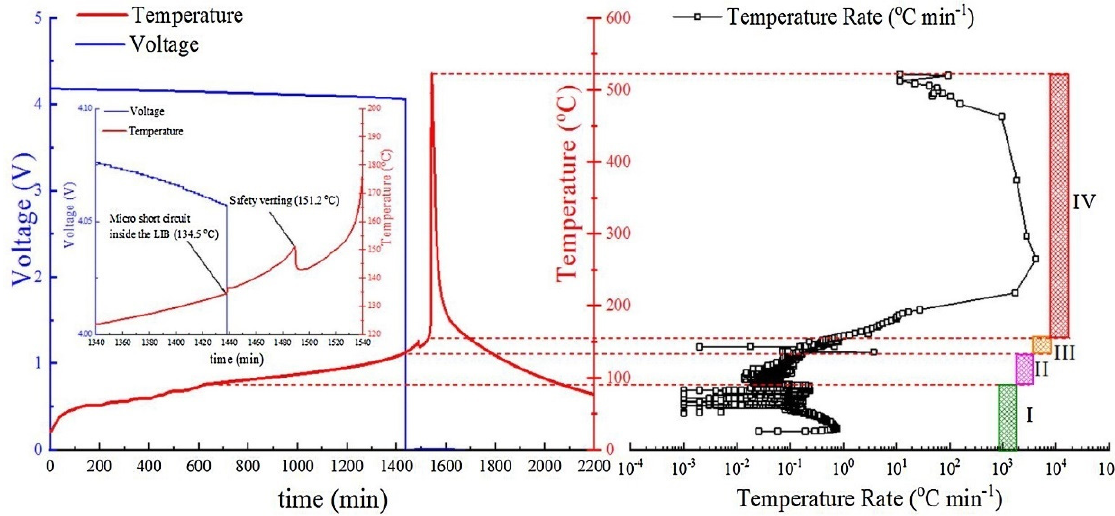
Figure 1. Voltage and temperature of temperature-induced thermal runaway [26].